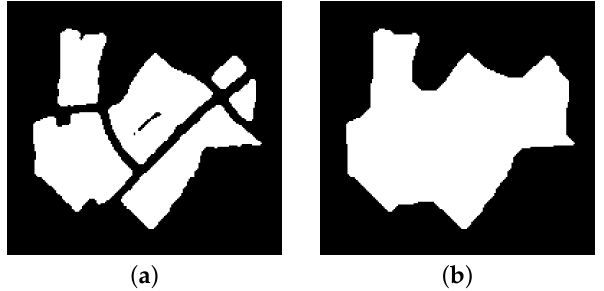
Figure 7. One local area with several separated ROIs. ( a ) Before the morphological operation. ( b ) After the morphological